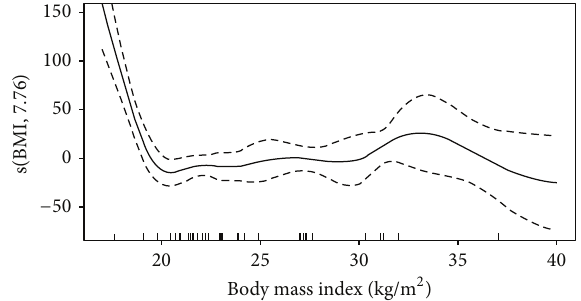
Figure 4: Association between IL13 levels and body mass index. Intervals are Bayesian credible